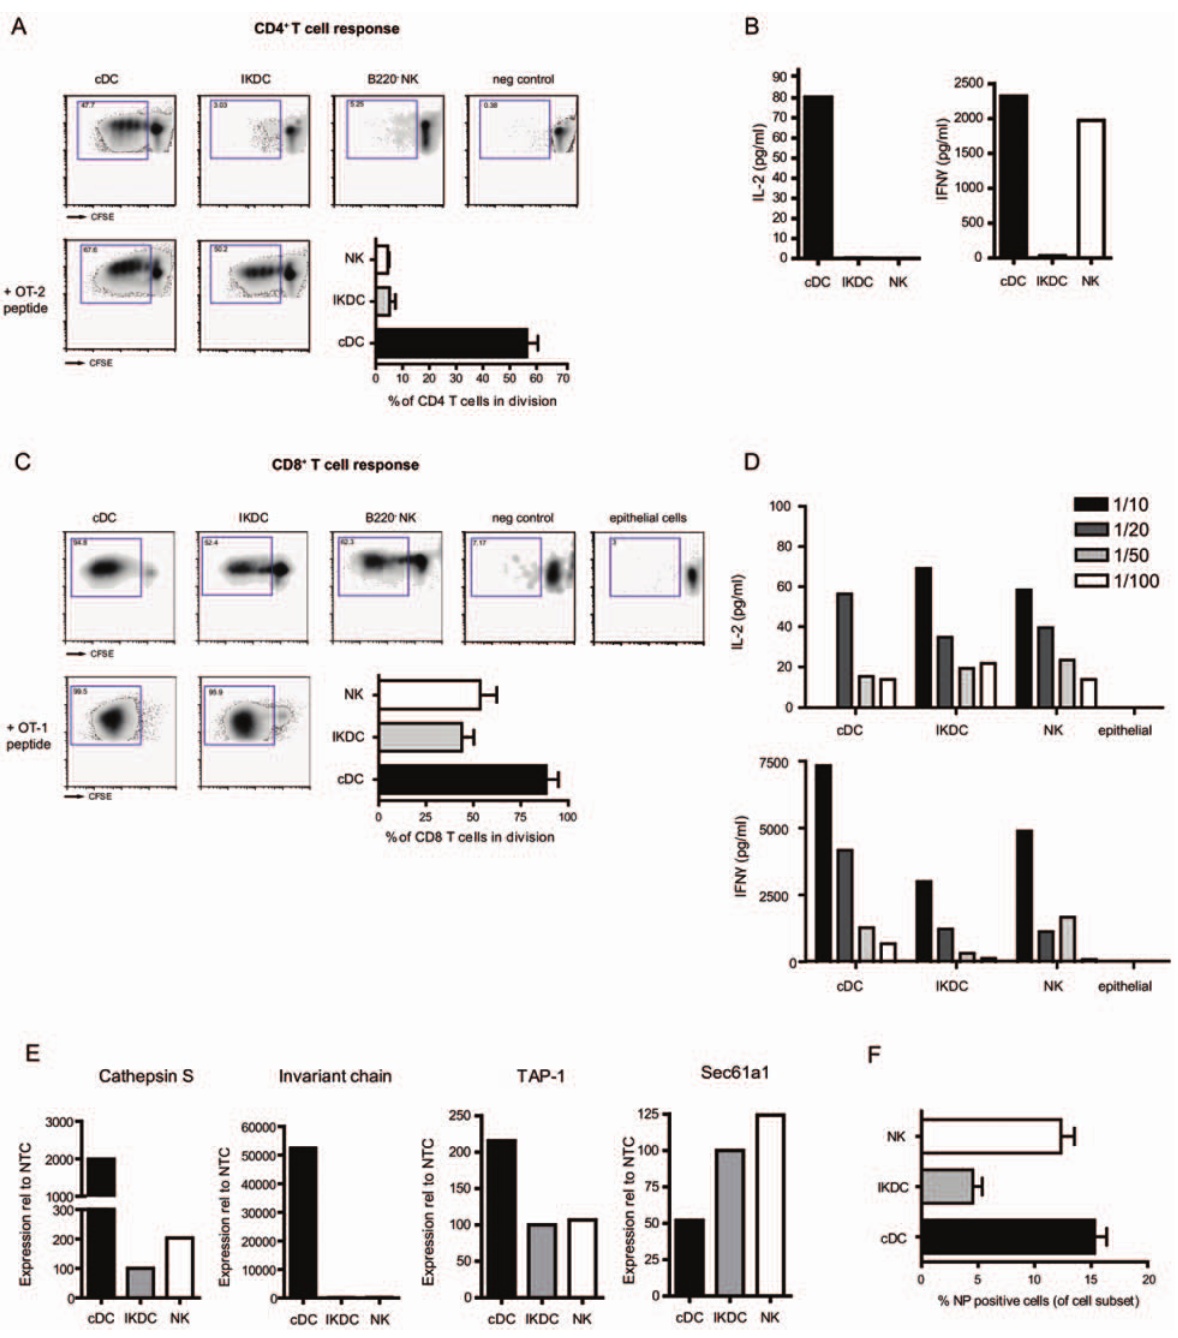
Figure 4. Antigen-presenting capacity of lung cDCs and NK cell subsets. Lung populations were sorted following the gating strategies in Figure 1. (A) CFSE-labelled OT-2 (CD4 + ) – T cell proliferation 4 days after co-culture with cDCs, IKDCs and B220 2 NK cells sorted from lung tissue of mice infected with PR-8 containing the OVA-CD4 + epitope. Negative control sample indicates co-culture of OTII cells with cDCs derived from a mouse infected with a MHCI-OVA epitope containing virus. Histogram represents average % of cells divided, from 3 seperately performed experiments. Lower left plots indicate T cell proliferation after addition of OT-2 peptide to the co-cultures. (B) Histogram represent IL-2 and IFN- c levels in supernatant of OTII co-cultures (C) Panel shows the same data for CFSE-labelled OT-1 (CD8 + ) - T cell proliferation 4 days after co-culture with cDCs, IKDCs, B220 2 NK cells and CD45-negative epithelial cells sorted from lung tissue of mice infected with WSN containing the OVA-CD8 + epitope. Negative controls in this setting are co-culture of OTI cells with cDCs derived from a mouse infected with a MHCII-OVA epitope containing virus. Numbers in top left corners of all plots represent the percentage of cells recruited into cell division and the histogram shows average % cell divisions of 3 separate experiments. (D) Histograms represent IL-2 and IFN- c levels in supernatant of OTI co-cultures with different ratios of DCs versus OTI T cells. (E) Expression of TAP-1, Sec61a1, Cathepsin S and invariant chain on sorted cell subsets at 4 dpi. Bars represent the values of expression relative to NTC. (D) Percentage of cells that have nucleoprotein (NP) positivity, measured by flowcytometry, and indicating replicative infection. Bars represent an average of at least 5 mice/group + / 2 SEM.